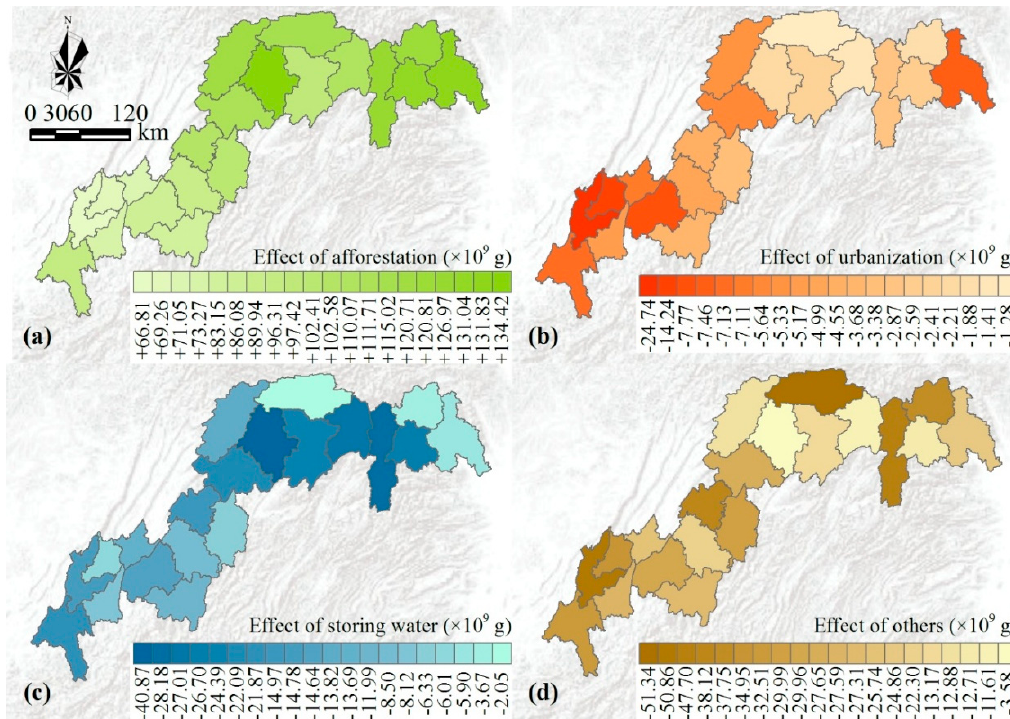
Figure 5. Spatial variations of the effects of afforestation ( a ); urbanization ( b ); storing water ( c ), and other land use changes ( d ) on NPP change at the county level.